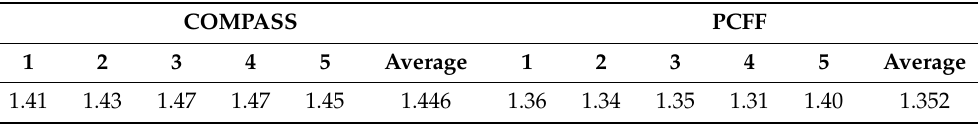
Table 3. Average values of E , G , v , and C12-C44 calculated using different force fields. COMPASS PCFF